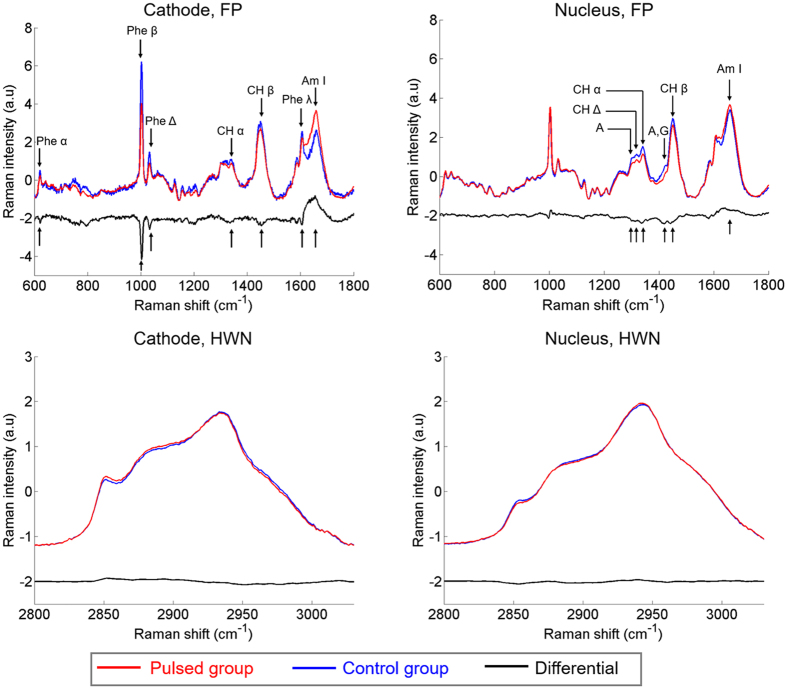
Mean normalized Raman signatures of pulsed and control haMSC cells.The differential spectrum (pulsed group minus control group) is also displayed. For more clarity, differential spectra are displayed with vertical offset. The black arrows indicate the discriminant peaks in the “Cathode, FP” and “Nucleus, FP” conditions. The pulse conditions are 8 pulses, 100 μs, 1 000 V/cm and 1 Hz.